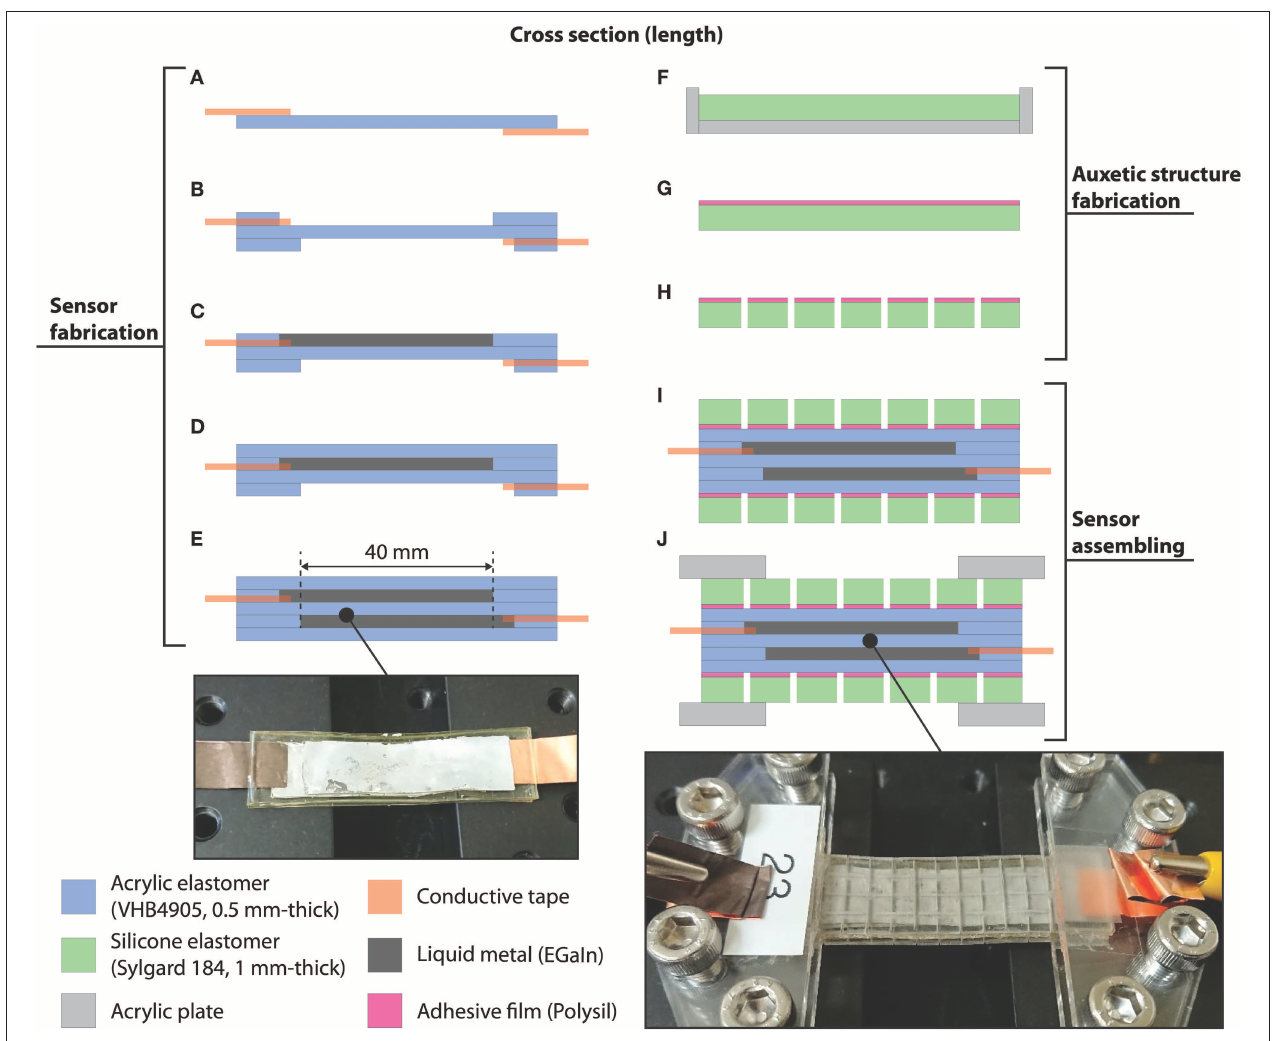
FIGURE 2 | Fabrication process of the sensor sample. (A–E) Fabrication of the base sensor. (A) A sheet of the acrylic layer is cut and a conductive tape is placed on both sides of the layer. (B) Additional acrylic layers with the electrode shape are attached. (C) EGaIn is filled and (D) sealed with another acrylic layer. (E) Repeating the steps (B–D) on the other side. (F–H) Fabrication of the auxetic structure. (F) The silicone elastomer is poured into a mold and cured. (G) A silicone adhesive film is attached onto the silicone elastomer. (H) The whole sheet is cut. (I,J) Assembling of the parts. (I) The auxetic structures are attached on both sides of the base sensor. (J) Holders are